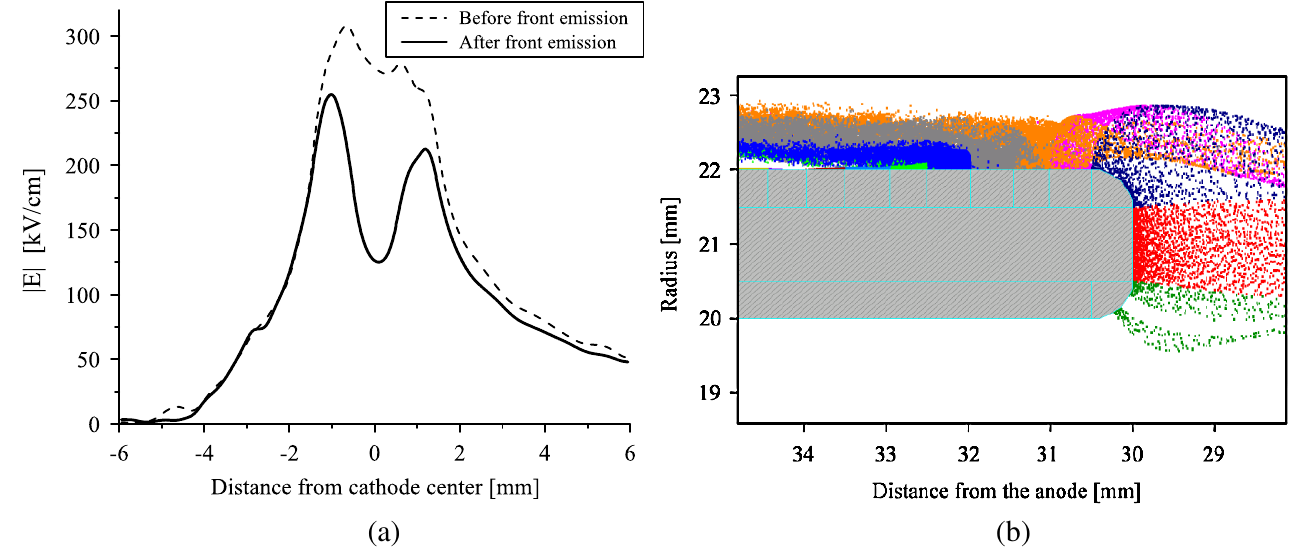
FIG. 8. (Color) The change in electric field when the front emission occurred (a) and the beam trajectory (b). The front emission occurred when the A-K gap voltage reached 600 kV.